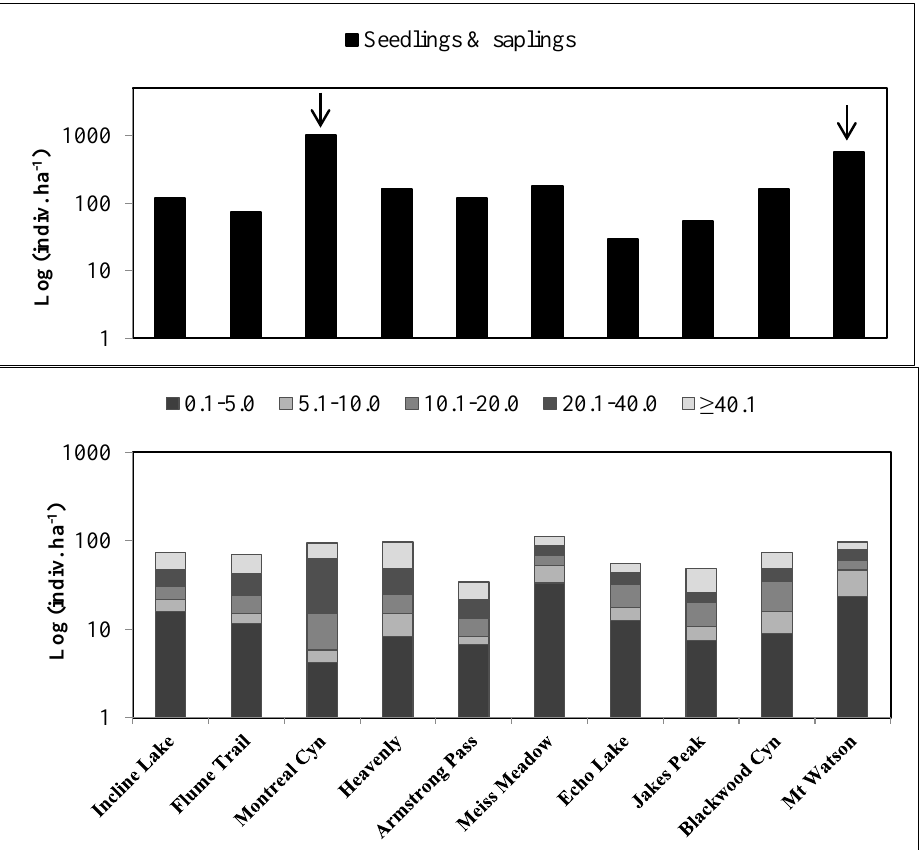
Figure 2. Seedling and sapling abundance and size structure for ten population of western white pine in the Lake Basin. Population structure is represented by stems in d.b.h. size classes 0.1–5.0 cm, 5.1–10.0 cm, 10.1–20.0 cm, 20.1–4.0 cm , and ≥40.1 cm. Arrows denote populations that were recently logged.